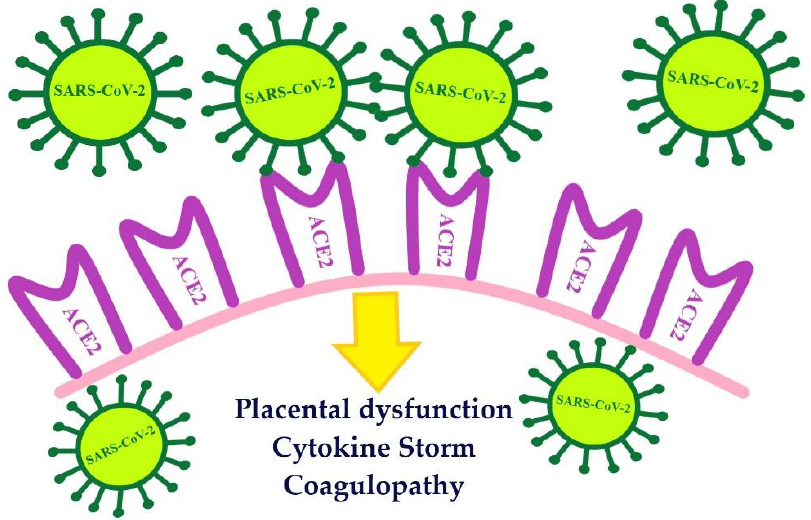
Figure 2. The number of ACE2 receptors increases during early and mid-pregnancy. ACE2 are receptors for the entry of SARS-CoV-2 into placental cells. ACE2-angiotensin-converting enzyme- related carboxypeptidase; SARS-CoV-2-severe acute respiratory syndrome coronavirus 2.